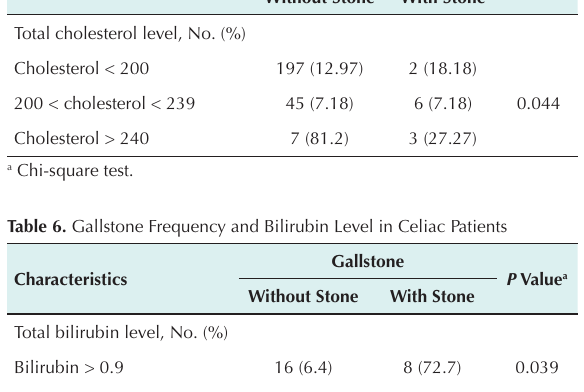
Table 5. Gallstone Frequency and Cholesterol Level in Celiac Patients Characteristics